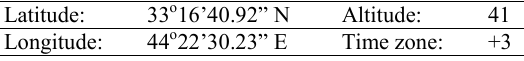
Table 8. The geographical locations of the PV system.